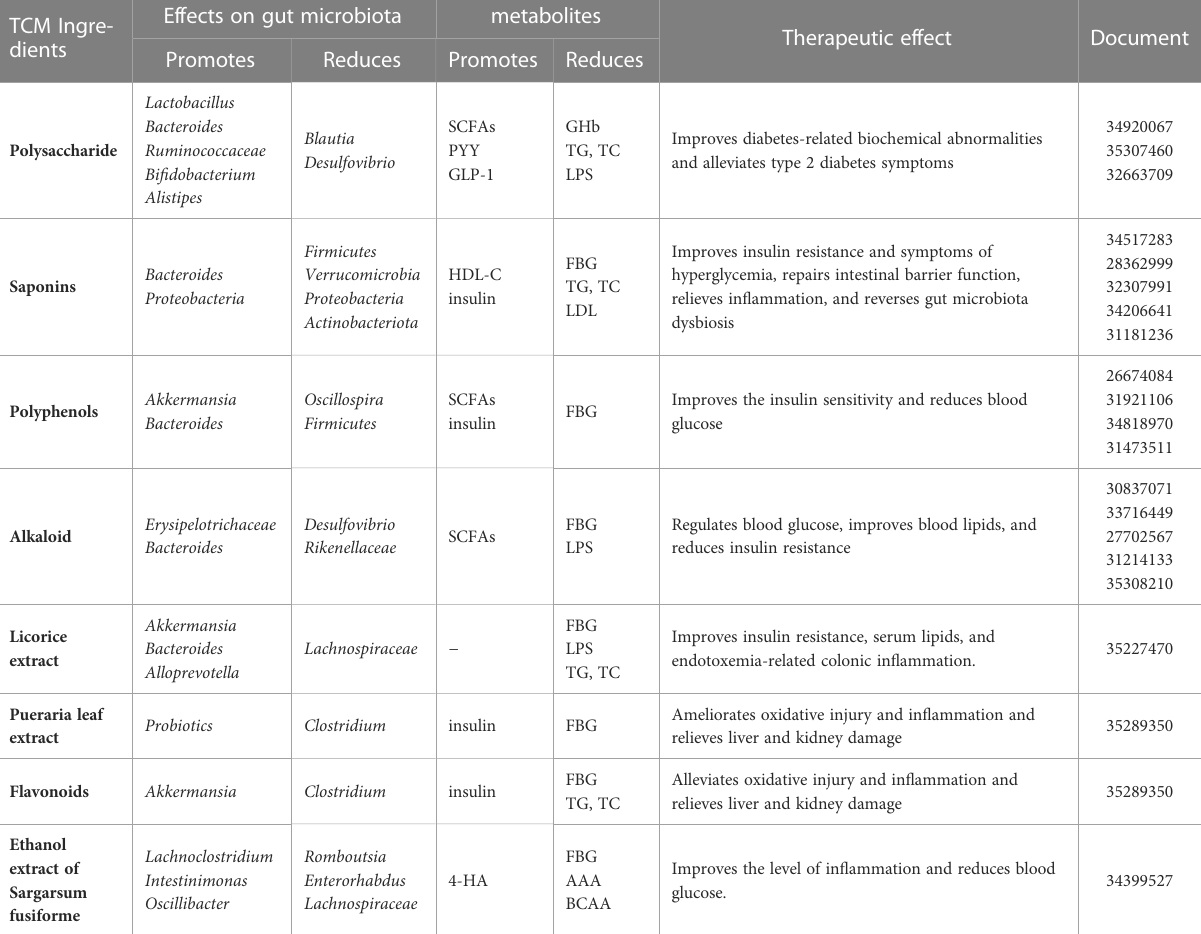
TABLE 1 Progress on the mechanism of Chinese medicinal ingredients acting on intestinal microbiota in the treatment of diabetes. TCM Ingre-